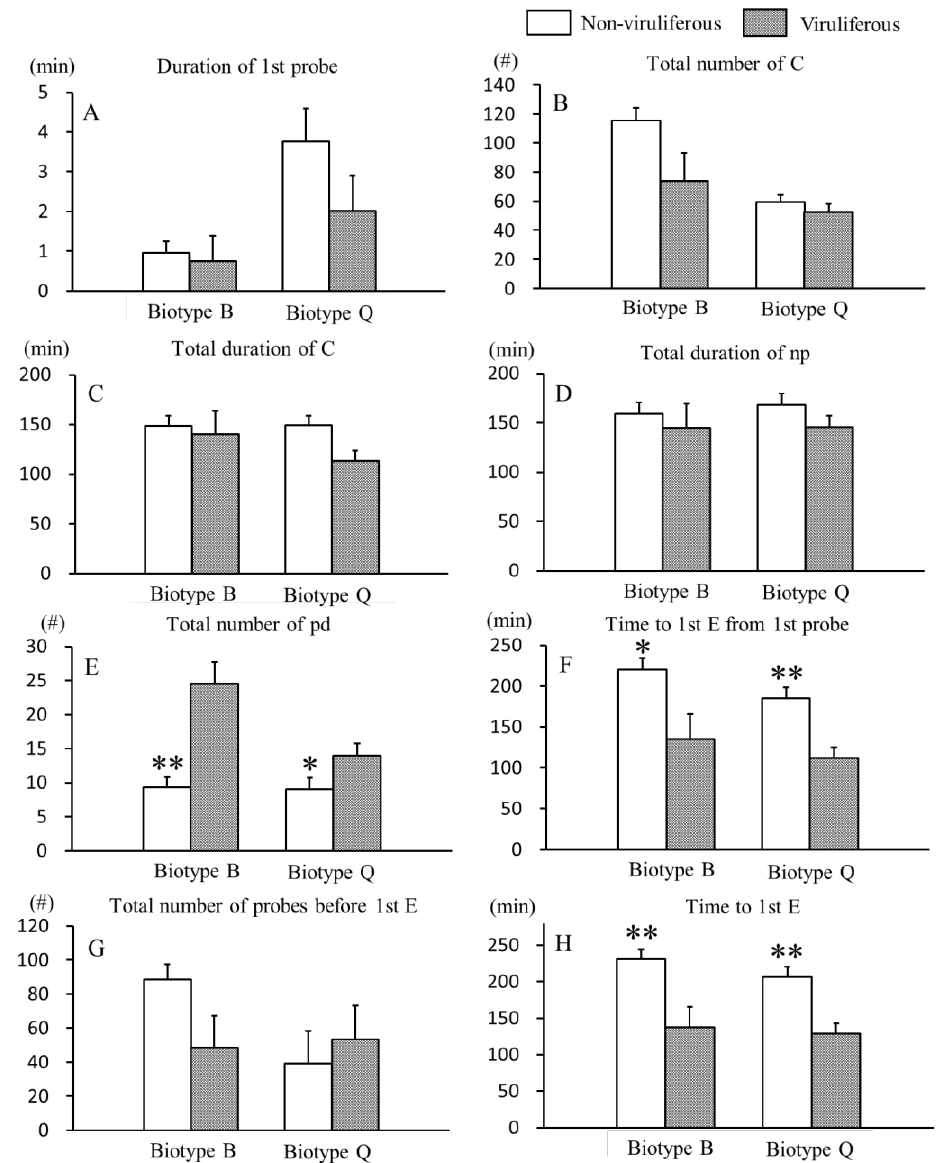
Figure 1. Non-phloem electrical penetration graph (EPG) variables of B. tabaci B and Q biotypes with cucurbit chlorotic yellows virus (CCYV). Data are means ± SE; bars with asterisk(s) (* or **) indicate a statistically significant difference between the non-viruliferous and viruliferous whiteflies of same biotype at p < 0.05 or p < 0.01 (Mann-Whitney test). EPG waveforms: C = pathway; np = non-probing/penetration; pd = potential drop (intracellular puncture); E = phloem salivary secretion and/or sap